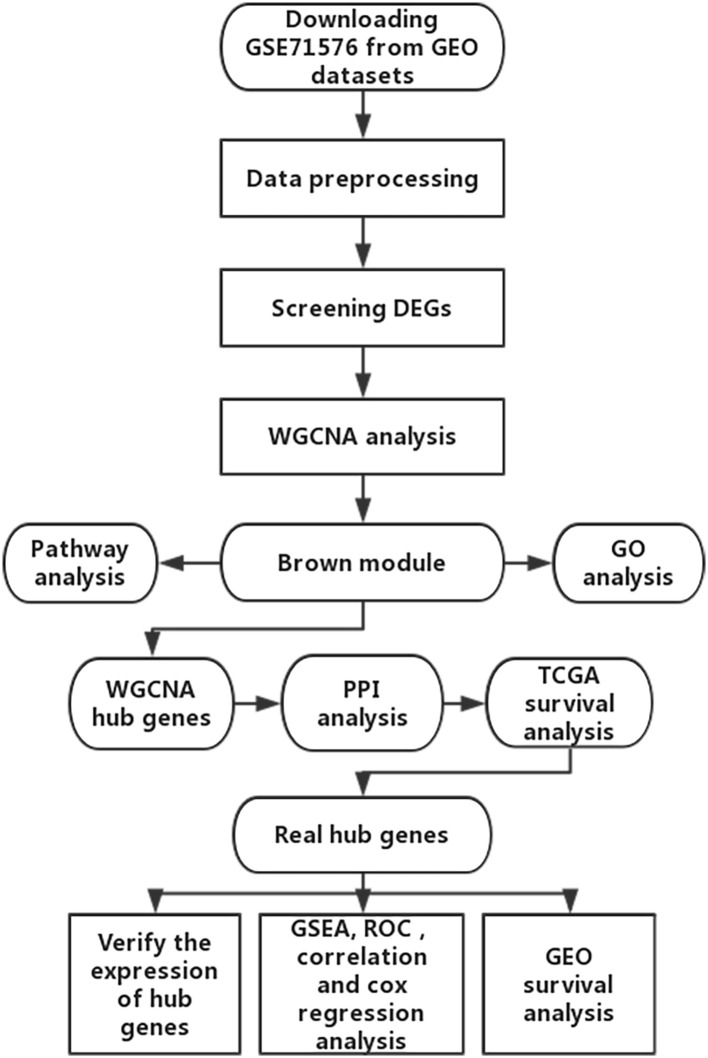
Flow diagram of the study.